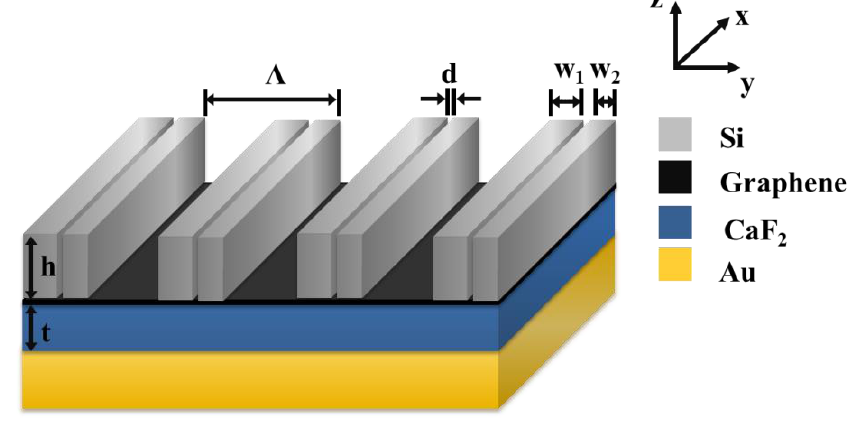
Figure 1. Schematic diagram of the proposed absorber.